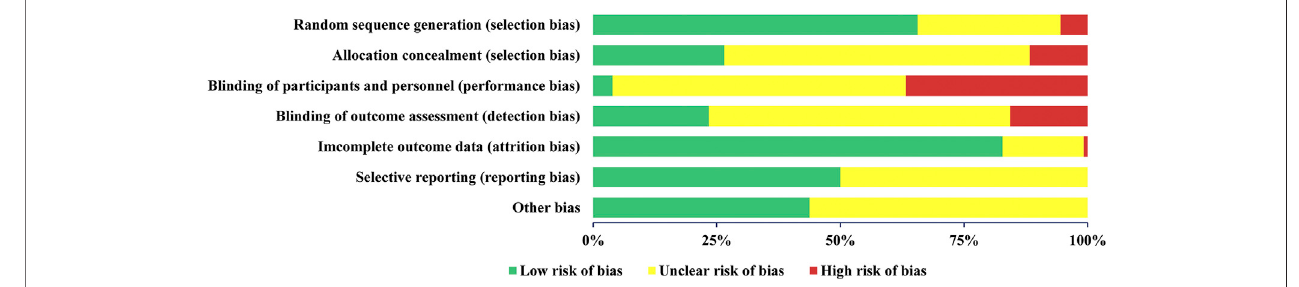
FIGURE 4 | Summary of the risk of bias of the randomized controlled trials (RCTs) included in the systematic reviews (SRs).